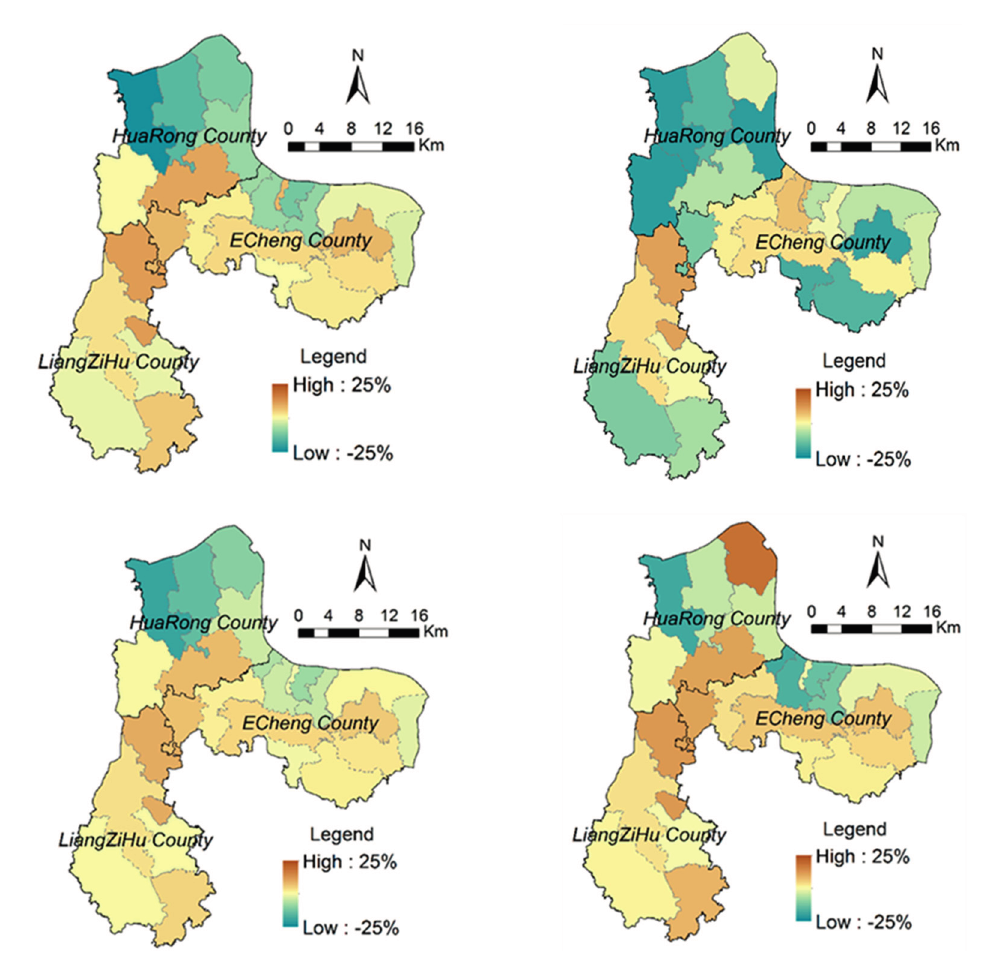
Figure 9. Spatial patterns of change ratios in town-level ecological risks in 2030 for different scenarios (with respect to